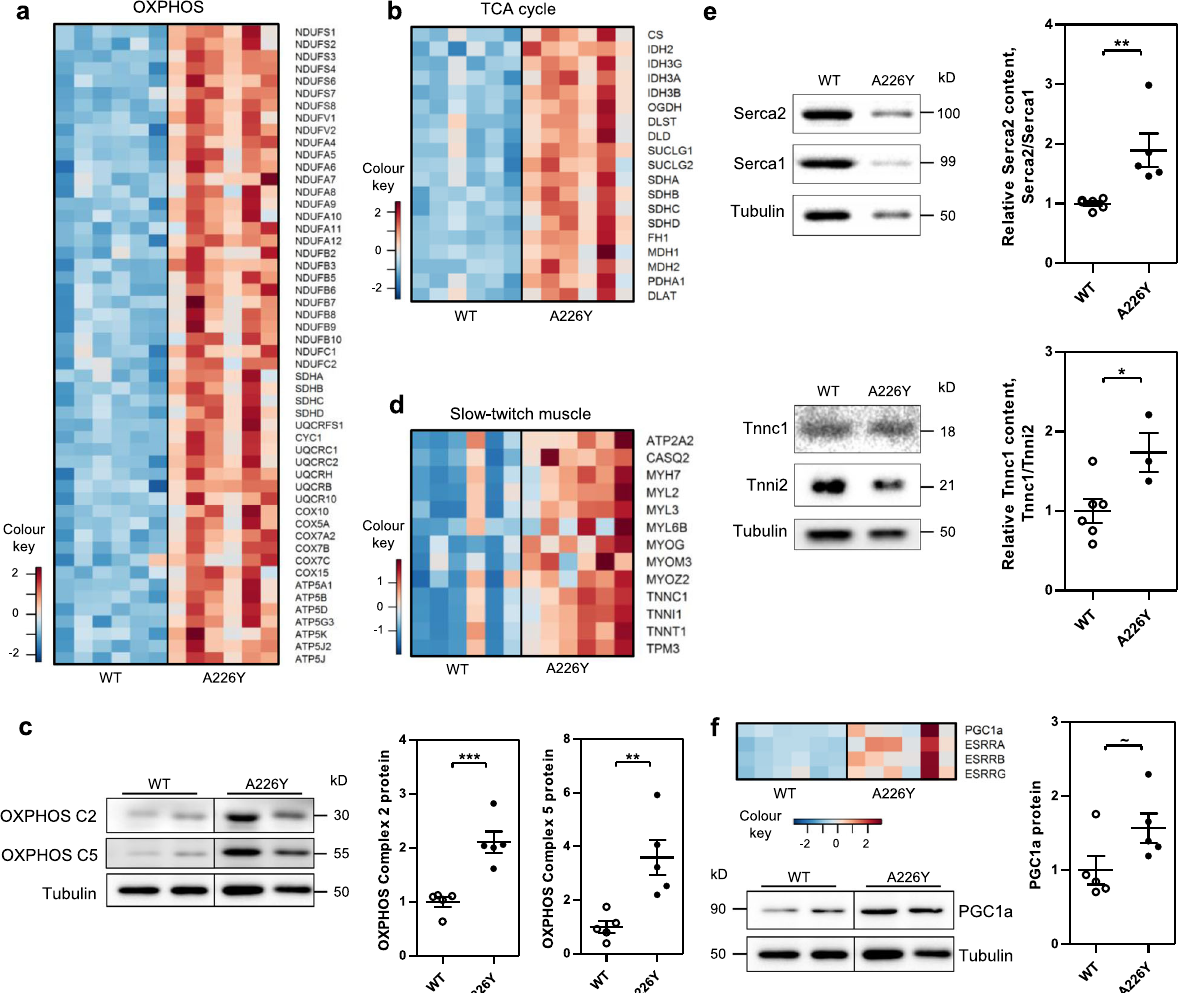
Fig. 2 Impact of mistranslation in the muscle of Rps2 A226Y mutant mice at 9 months of age. Graphs show mean, SEM, and individual data points. *** p < 0.001, ** p < 0.01, * p < 0.05, ~ p < 0.1. a Heatmap showing the signi fi cantly regulated genes (FDR < 0.05) in the KEGG pathway ‘ Oxidative Phosphorylation (mmu00190) ’ . b Heatmap showing the signi fi cantly regulated genes (FDR < 0.05) in the KEGG pathway ‘ Citrate cycle (TCA cycle) (mmu00020) ’ . c Western blot and densitometry of OXPHOS Complex 2 (SDHB) and OXPHOS Complex 5 (ATP5A) proteins as indicators of mitochondrial content in 9 months WT and A226Y ( N = 5). Tubulin as loading control. d Heatmap showing the signi fi cantly regulated genes ( p < 0.05) associated with slow-twitch muscle fi bers. e Western blots of Serca1 and Serca2 levels, and Tnnc1 and Tnni2 levels, in WT and A226Y mouse skeletal muscle. Tubulin as loading control. Graphs show the densitometry of Serca2/Serca1 and Tnnc1/Tnni2 ratios. All values were fi rst normalized to tubulin as loading control (3 ≤ N ≤ 6). f Heatmap showing expression of key regulators of mitochondrial biogenesis: PGC1a, ESRRA, ESRRB, and ESRRG. Western blot plus densitometry of PGC1a protein level in 9 months WT and A226Y ( N = 5). Tubulin as loading control. N = number of independent mice in each